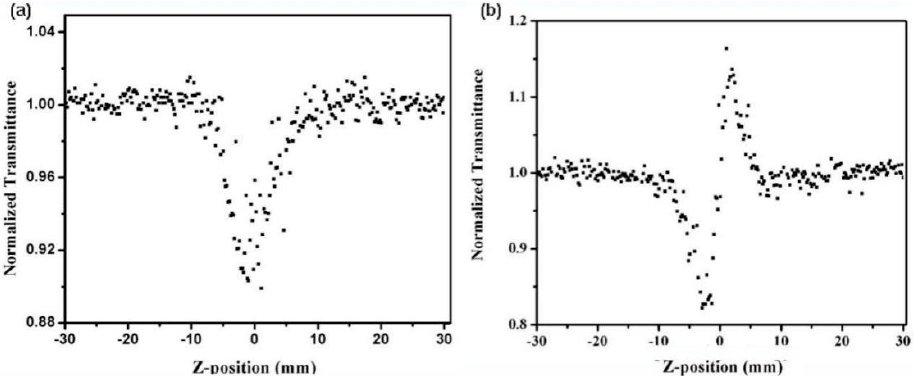
Figure 7. ( a ) The open-aperture Z-scan curve of BTN in 2 mm thick quartz sample cell. ( b ) The closed-aperture Z-scan curve of BTN in 2 mm thick quartz sample cell.